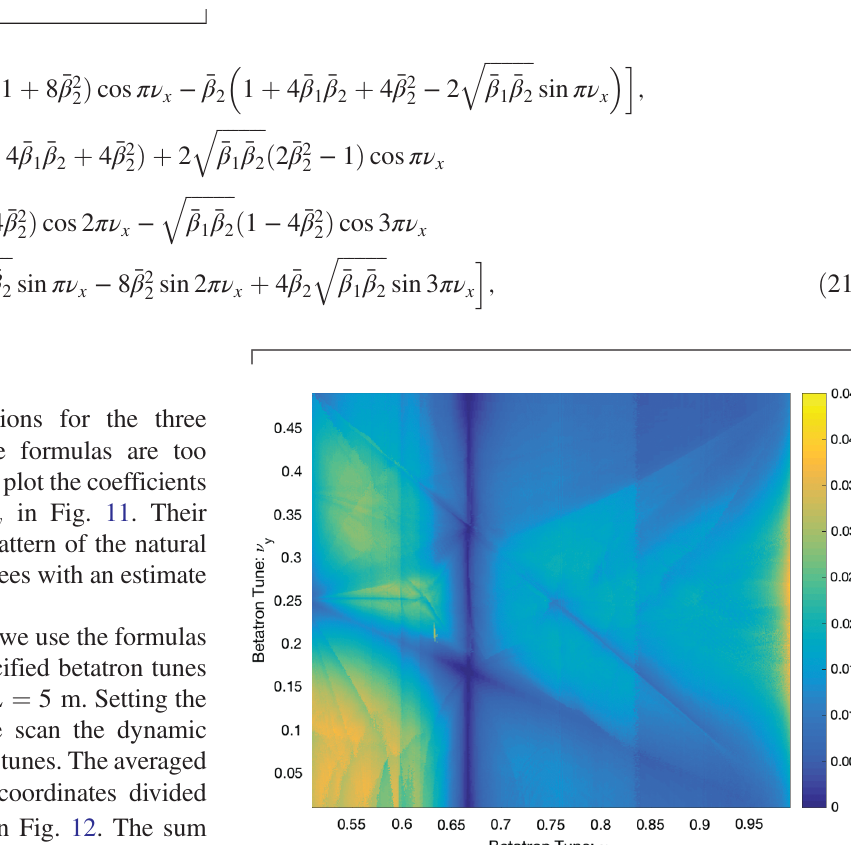
FIG. 11. The coefficients of resonance driving terms: 3 ν ∶ ν 1 ∶ 4 ; 1 ∶ 3 , and 1 ∶ 2 represented by blue, red, and black color respectively. ratios: ν y x ¼